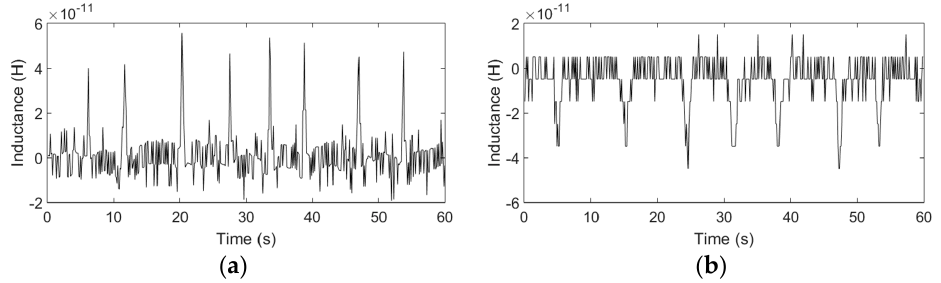
Figure 8. Detection results of iron and copper particles, the frequency was 2 MHz and each coil had 20 turns: ( a ) iron particles with sizes ranging from 40 to 50 μ m; ( b ) copper particles with sizes ranging from 110 to 120 μ m.